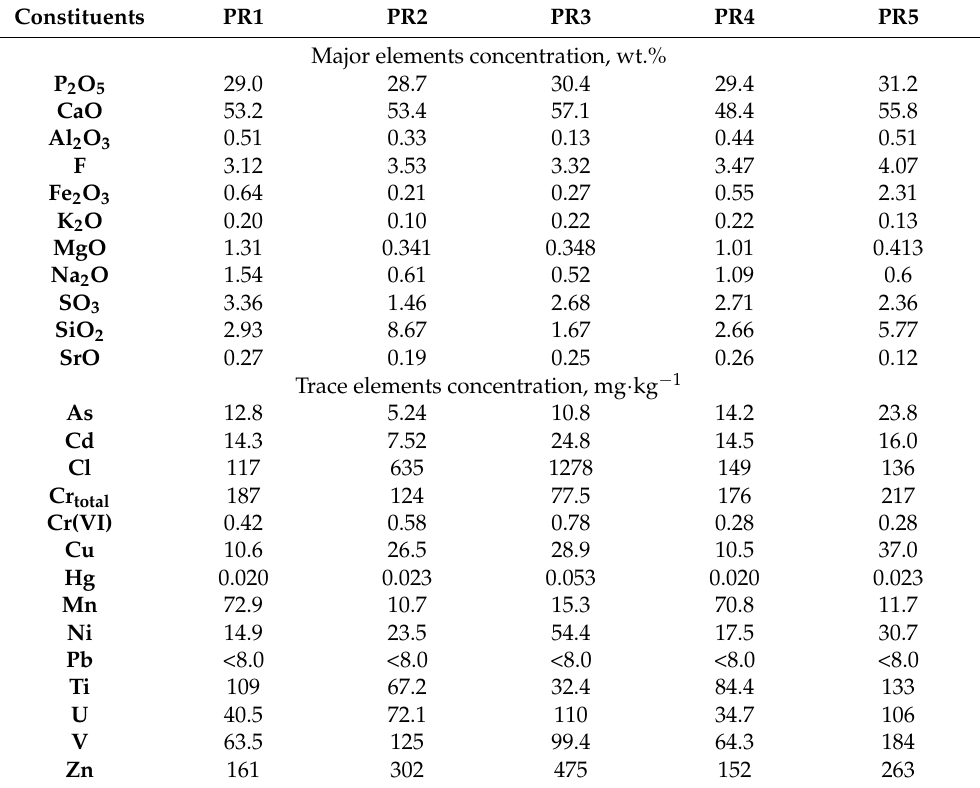
Table 5. The concentration of major and trace elements in the phosphate rocks from various origins. Constituents